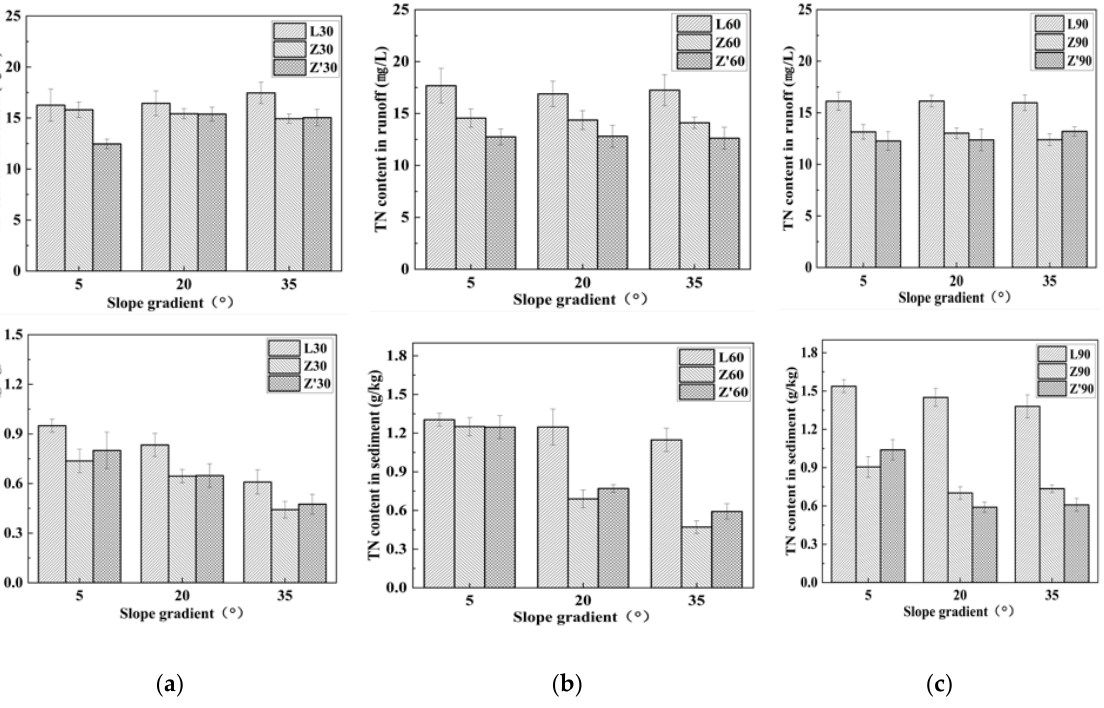
Figure 7. Effect of rainfall intensity, slope gradient on TN loss in runoff and sediment under different vegetation coverage types: ( a ) Rain intensity is 30 mm/h; ( b ) Rain intensity is 60 mm/h; ( c ) Rain intensity is 90